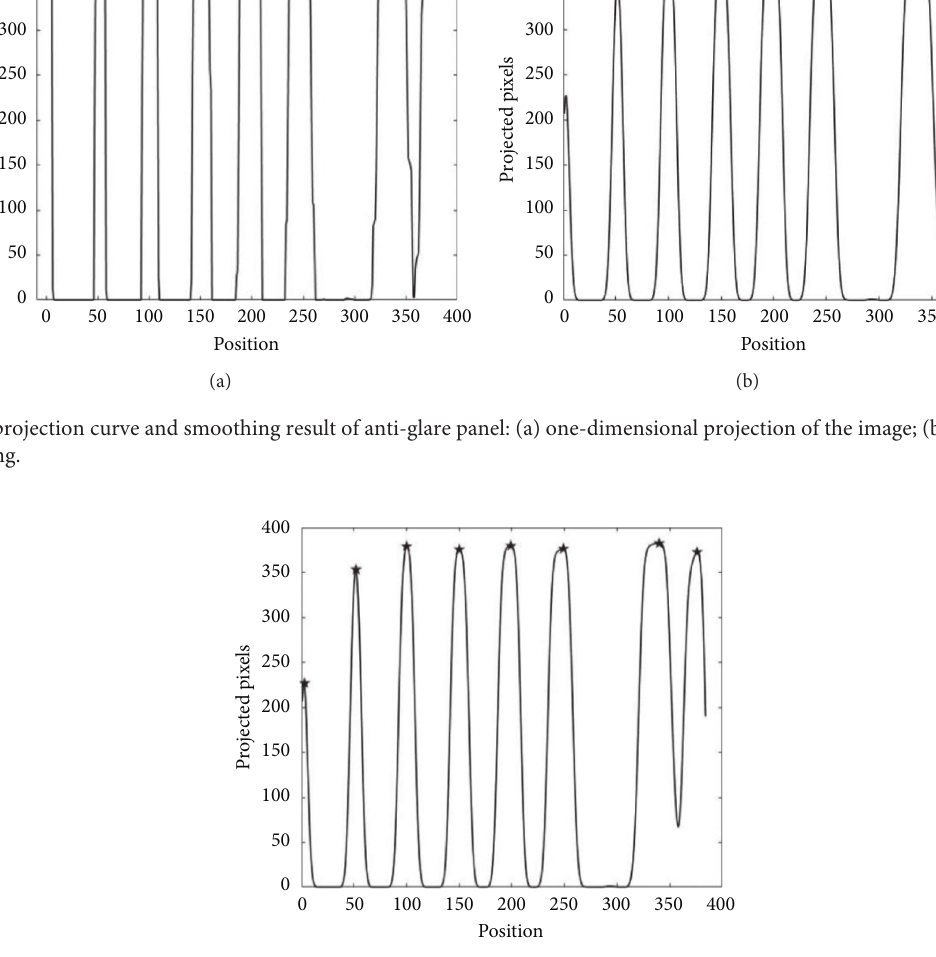
Figure 7: Local nonmaximum